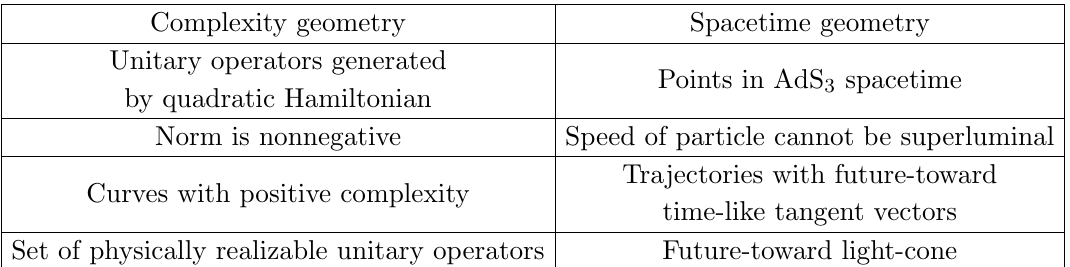
Table 1 . Comparison between the complexity geometry of SU(1,1) group and spacetime geometry of AdS 3